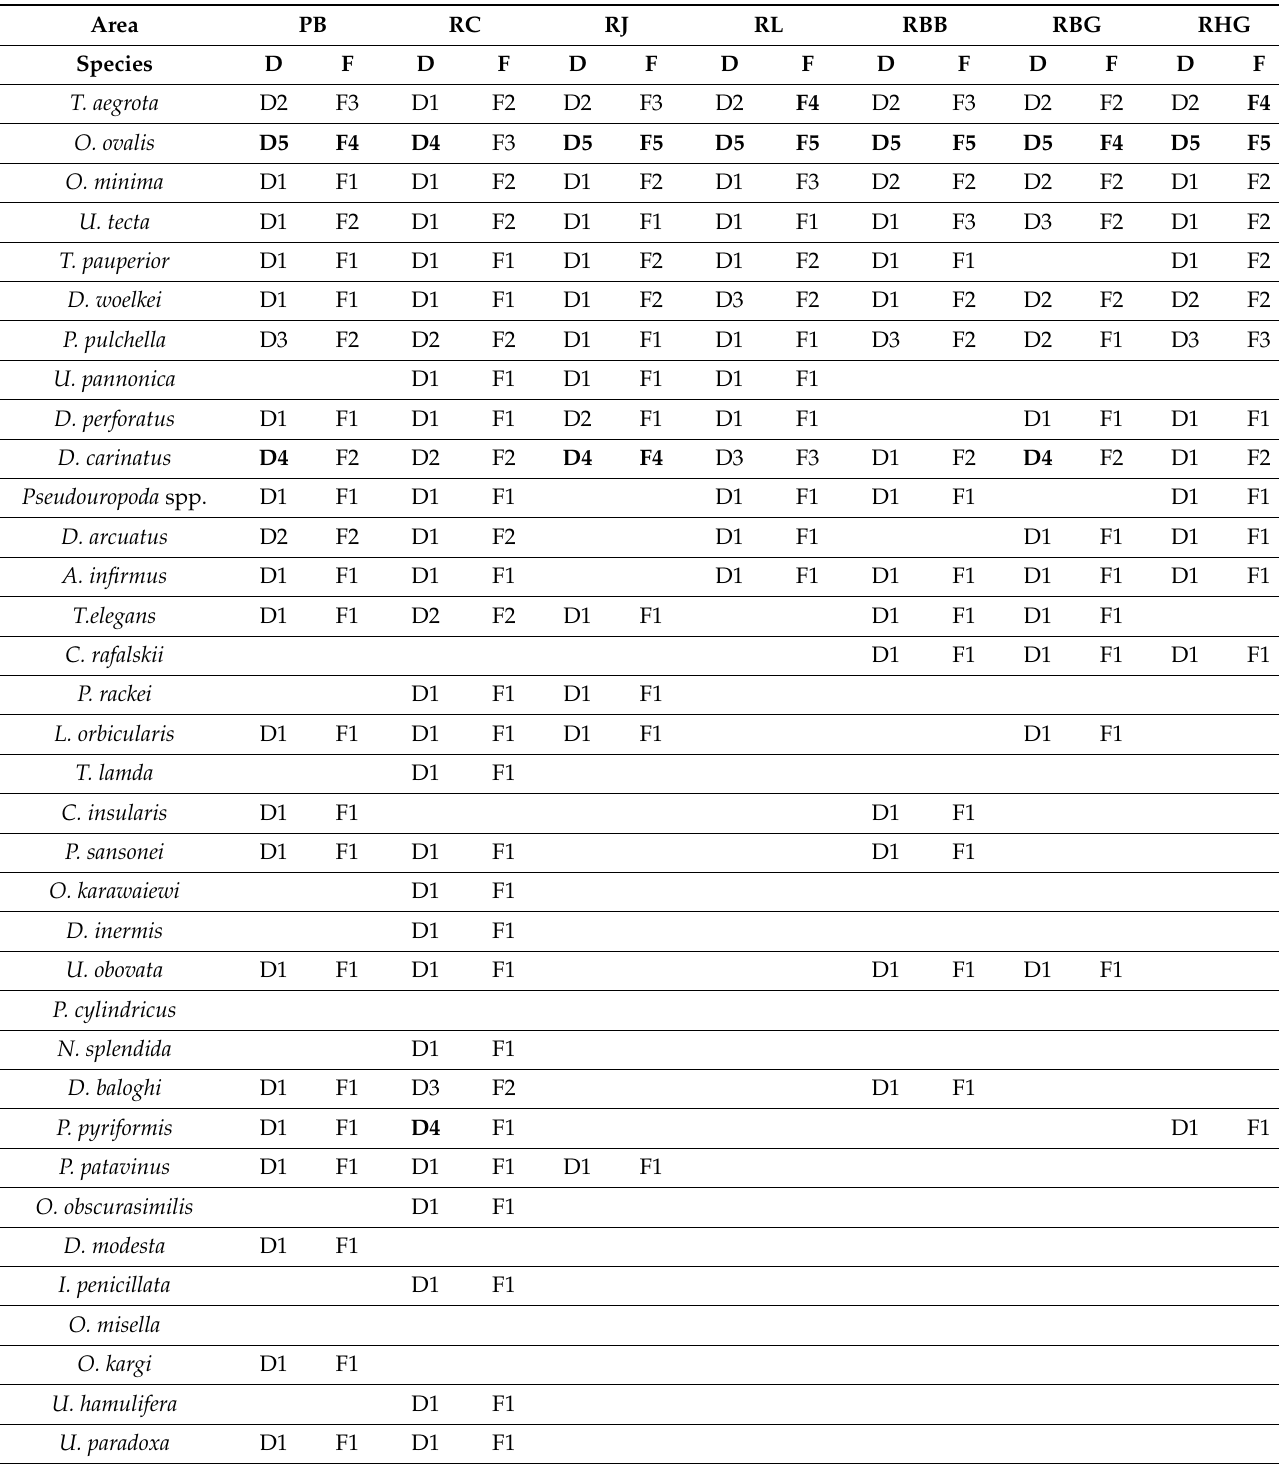
Table A1. Species composition and structure of Uropodine mites communities the in dead wood in the examined